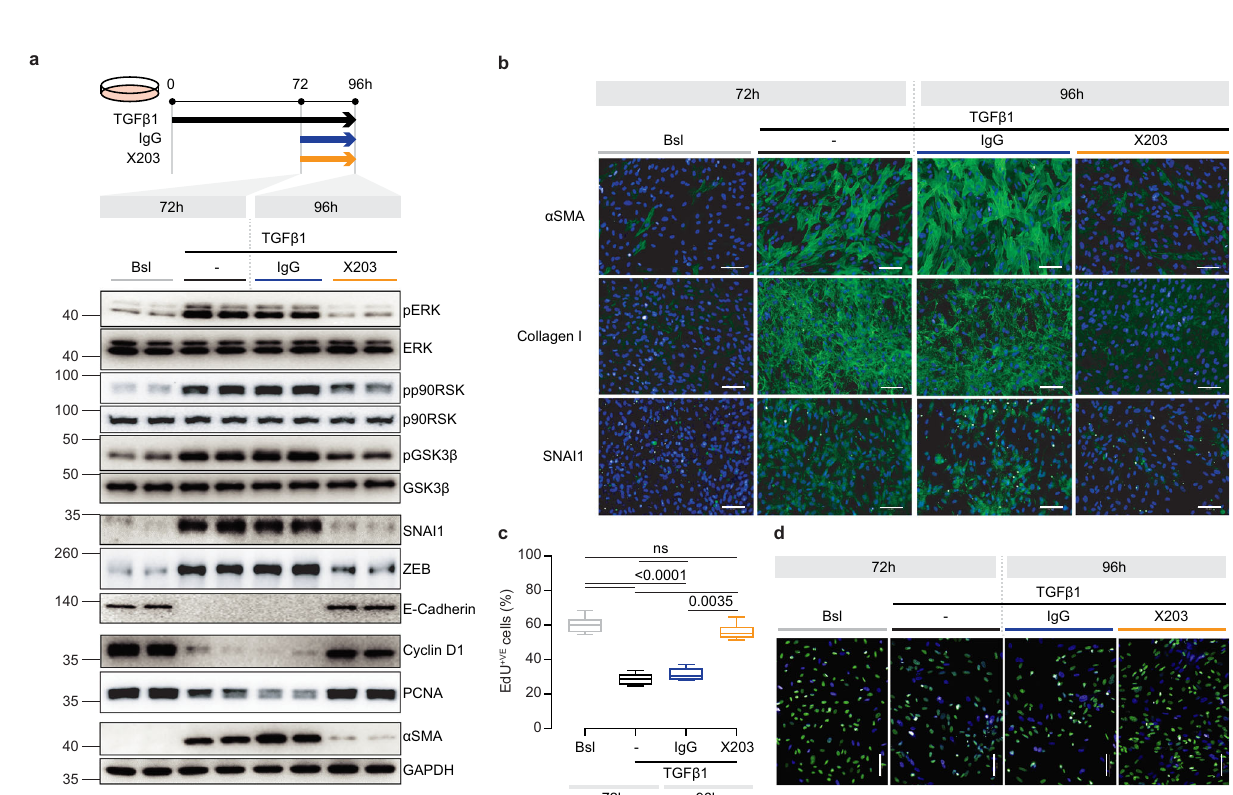
Fig. 7 | Deletion of Il11ra1 in tubular epithelial cells protects against acute kidney injury. a Schematic of induction of AKI injury in Cadh16-Cre +/- Il11ra1 loxP/loxP mice for experiments shown in ( b – i ). Cadh16-Cre +/- Il11ra1 loxP/loxP and littermate control (Cadh16-Cre − / − Il11ra1 loxP/loxP ) mice were injected intraperitoneally with 200mg/kg FA. Blood and kidneys were collected on day 28 post FA. b Western blots showing renal expression of IL11, pERK, ERK, pp90RSK, p90RSK, pGSK3 β , GSK3 β , SNAI1, ZEB, E-Cadherin, Cyclin D1, α SMA, Fibronectin (FN1), and GAPDH (representative dataset from n =5/group, except for WT-NaHCO 3 : n =4), c kidney weights, d kidney collagen content by hydroxyproline assay, e representative Masson ’ s Trichrome images of whole kidney cross section (scale bars: 500 µ m, representative dataset from n =5/group, except for WT-NaHCO 3 : n =4),